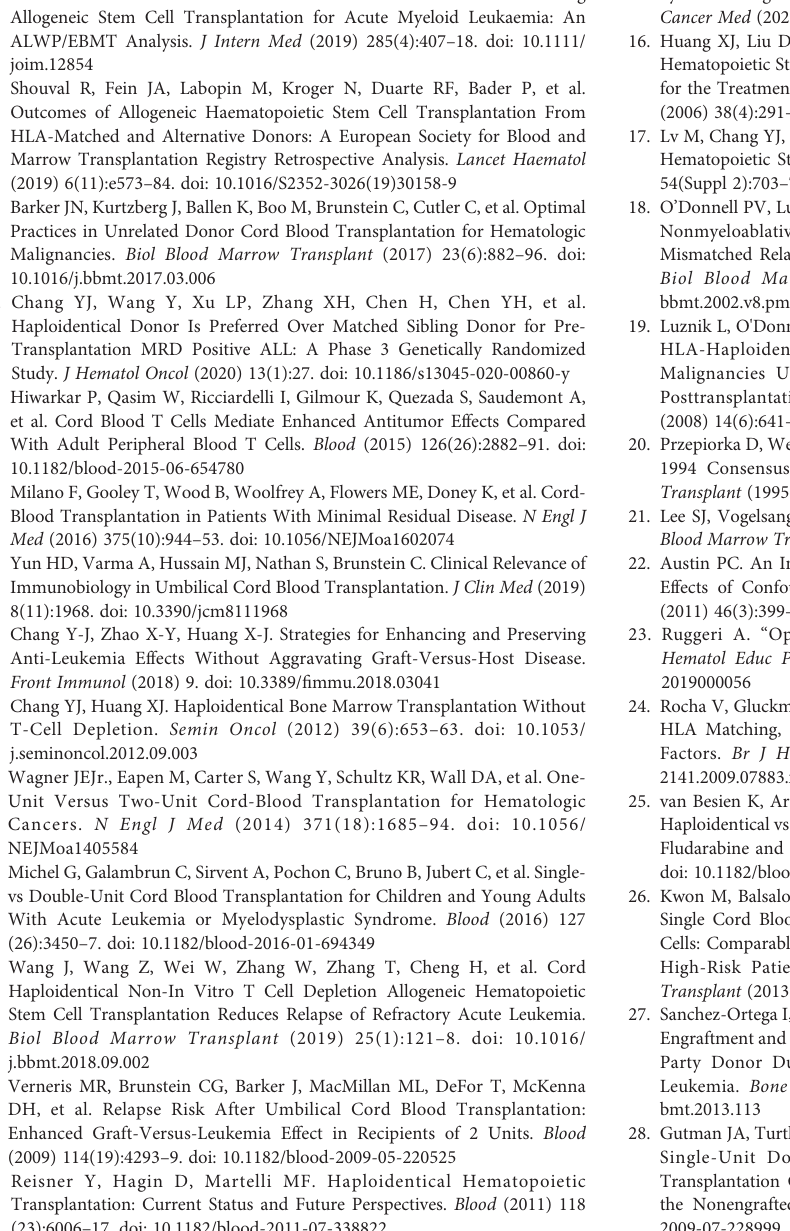
Supplementary Figure S2 | Distribution of the estimated propensity score in the haplo+cord and single cord group.